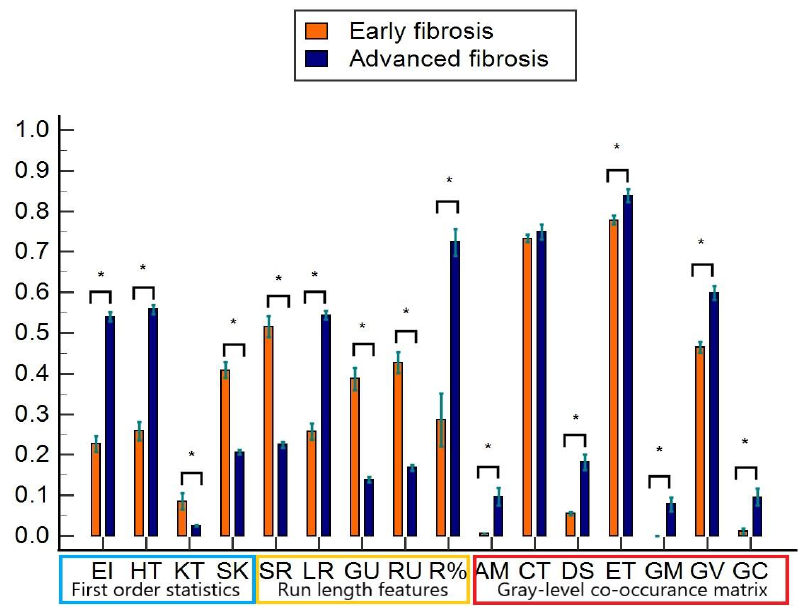
Figure 2. Comparison of image features on a normalized scale (0 – 1). Orange and blue bars represent early and advanced-stage fibrosis, respectively. EI: echo-intensity, HT: heterogeneity, SK: skewness, KT: kurtosis, SR: short run length, LR: long run length, GU: gray-level nonuniformity, RU: run length nonuniformity, R%: run percentage, AM: angular second momentum, CT: contrast, DS: dissimilarity, ET: entropy; GM: gray-level mean, GV: gray level variance, GC: gray-level correlation. * denotes statistical significance, p -value < 0.05. Table 1. The mean and standard deviation of the ultrasound texture features of early fibrosis compared to advanced liver fibrosis. GLNU: gray-level nonunformity; RLNU: run length nonuniformity; ASM: Angular second momentum; GLCM: gray level mean; GLCV: gray level variance; GLCC: gray level correlation.